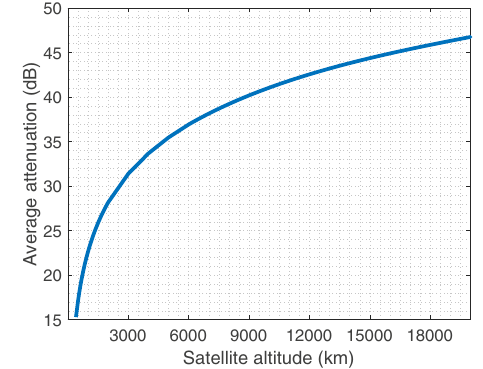
Fig. 4 Average attenuation. Average attenuation per pass as a function of satellite